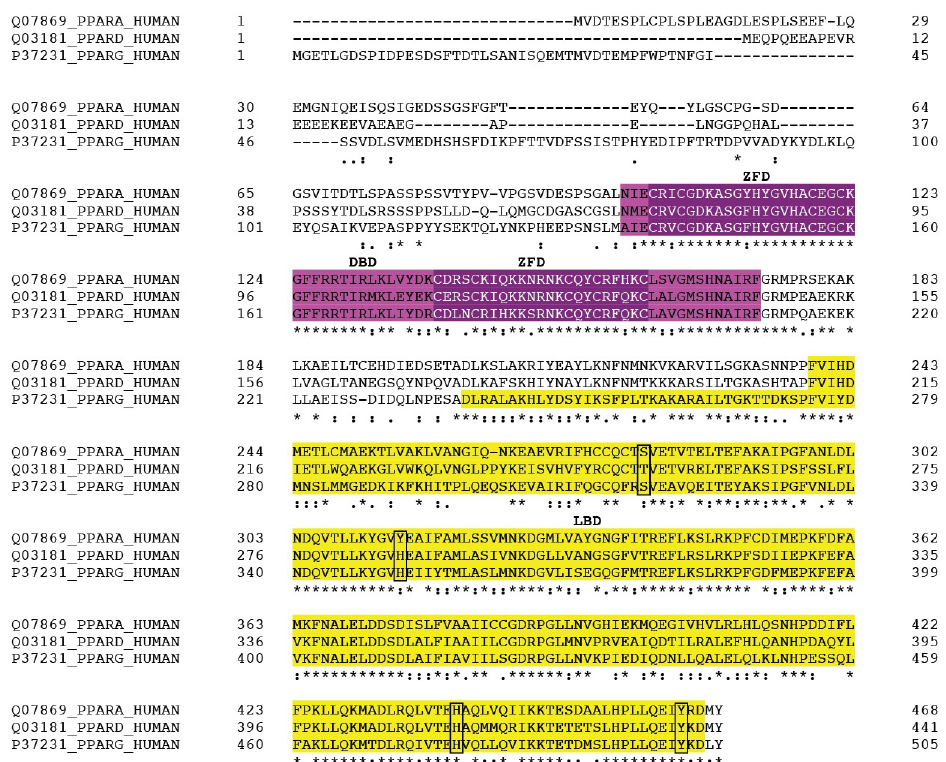
Figure 1. Amino acid sequence alignments of human peroxisome proliferator-activated receptors (PPAR) isoforms. DNA-binding domain (DBD, purple), zinc-finger domains (ZFD, purple), and ligand binding domain (LBD, yellow) are highlighted. All three isoforms of PPAR possess a high degree of inter-species sequence homology, particularly in the DBD and LBD. The sequence positions that are conserved within PPAR isoforms are important for identification of the structural dynamics, ligand affinity, and DNA binding specificity. Amino acid residues, which participate in ligand binding, are boxed. Alignment was performed with CLUSTALO (https://www.uniprot.org/align/). (*)—fully conserved residues; (:)— residues with strongly similar properties; (.)—residues with weakly similar properties.